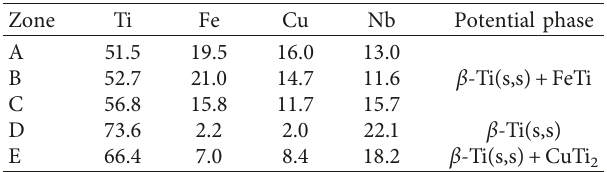
Figure 5: Microstructure of the fusion zone of the titanium alloy side: (a) EBW-1; (b) EBW-2. Table 4: The main chemical compositions of different zones (at %) in the fusion